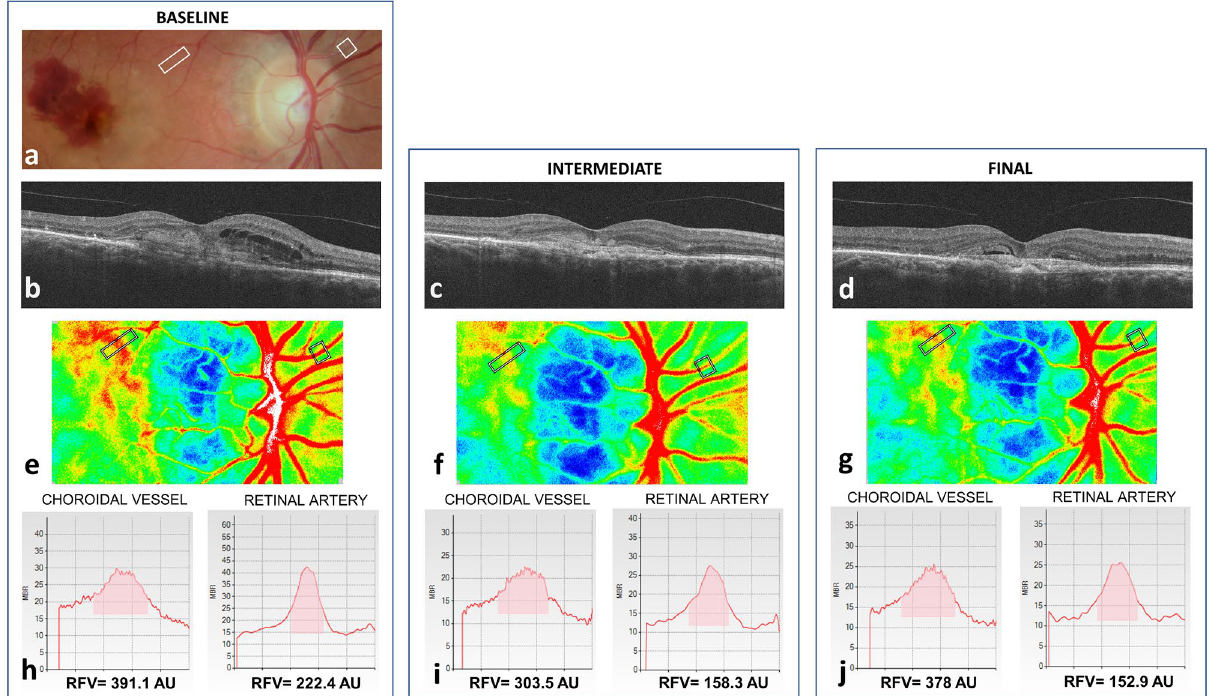
Figure 1. Laser speckle flowgraphy analysis. ( a ) Fundus photograph taken at baseline showing the rectangular regions of interest (ROI) used to analyze retinal and choroidal blood flow with LSFG. ( b – d ) Spectral-domain OCT showing the macular neovascularization before and after anti-VEGF treatment. ( e – g ) LSFG composite map showing the ROI used to analyze retinal and choroidal blood flow before and after anti-VEGF treatment. The ROI correspond to those shown in ( a ). ( h – j ) Quantitative blood flow analysis within the vessel segment of interest before and after anti-VEGF. In each graph, RFV (pink area) is obtained after subtraction of background Mean Blur Rate